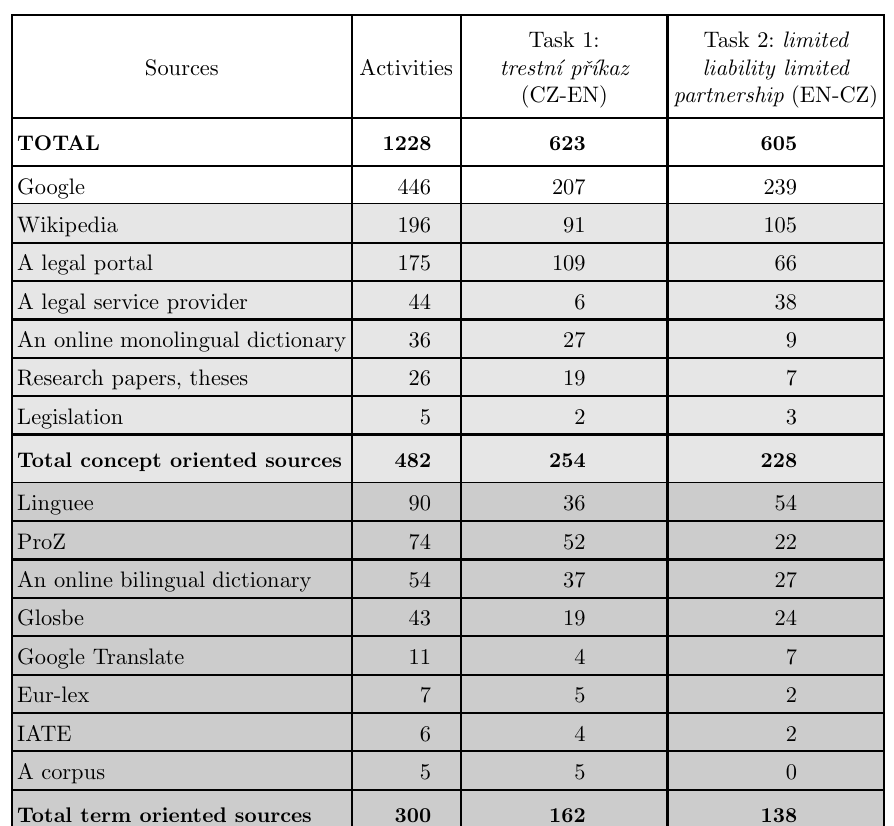
Table 1 Individual sources and source categories used by the subjects